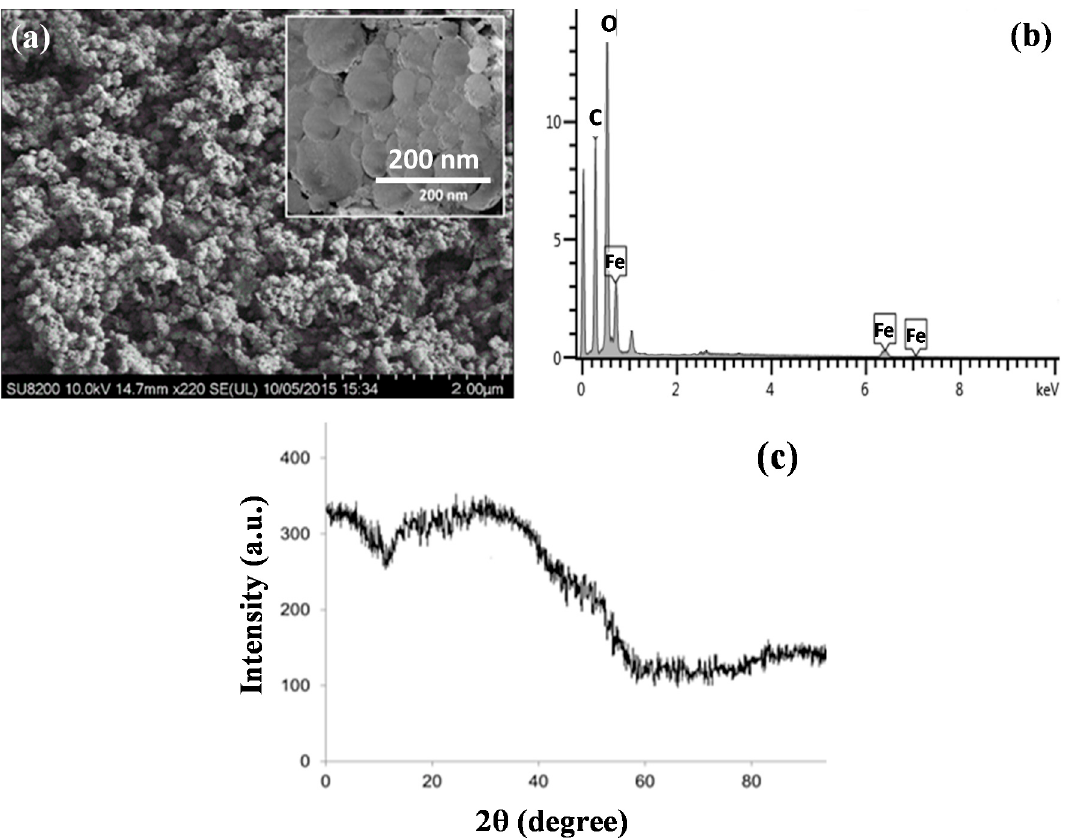
Figure 2. ( a ) SEM images of T. chebula -synthesized IONPs and ( b ) EDX profile of IONPs. ( c ) XRD pattern of T. chebula -synthesized IONPs.